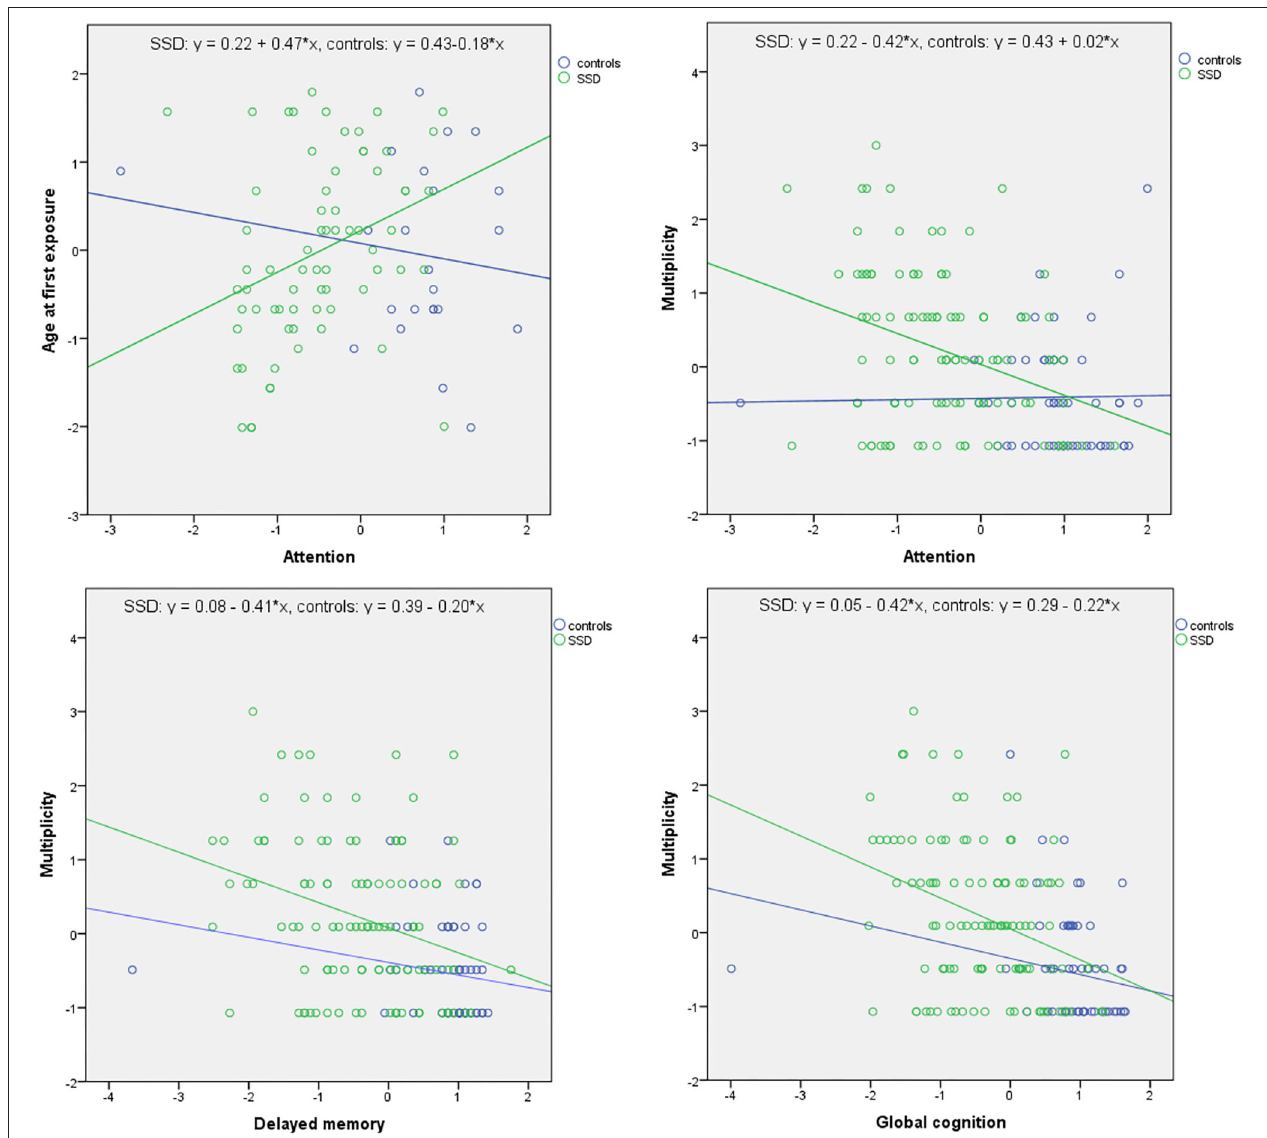
FIGURE 1 | Significant associations between the measures of ACEs and cognition in linear regression analyses. Data expressed as z -scores. There were significant main effects of multiplicity of ACEs on delayed memory ( B = − 0.201, p = 0.040) and global cognition scores ( B = − 0.220, p = 0.040). Additionally, significant effects of interactions between group and age at first exposure ( B = 0.650, p = 0.018) as well as between group and multiplicity ( B = − 0.440, p = 0.017) on attention scores were found. More specifically, younger age at first exposure and greater multiplicity of ACEs were associated with worse performance of attention in subjects with SSD but not in healthy